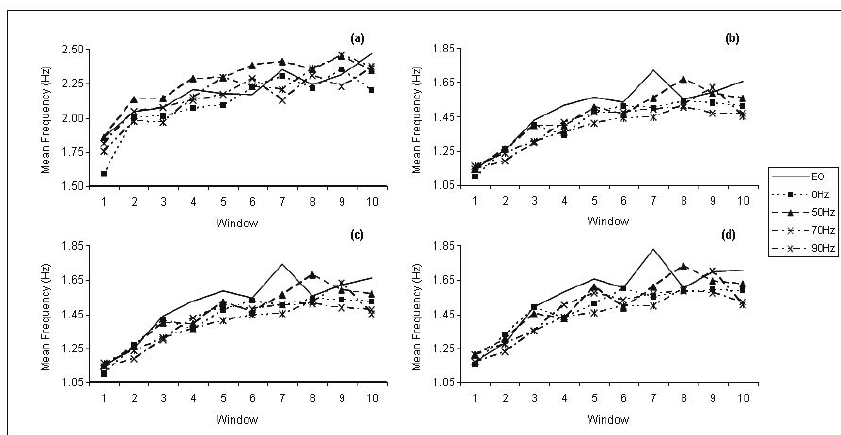
Figure 5. The effect of time on mean frequency estimation using Fourier–Bessel Expan- sion for 100-point windows (ML): (a) No window; (b) Hamming window, (c) Gaussian window ( (cid:5) D 2:5 ), (d) Kaiser window ( ˇ D 8 ).